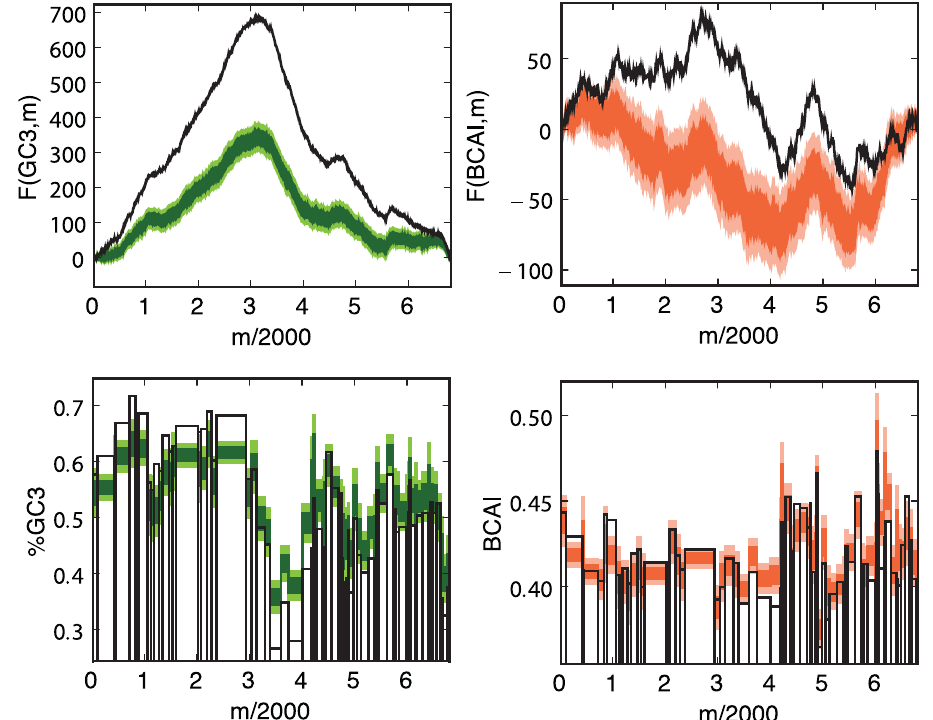
Figure 5. Observed and randomized landscapes for lambda phage. Observed landscapes are shown along with randomized landscapes associated with the green and orange tests. The green randomization procedure tests the significance of the GC3 landscape controlling for the observed CAI (actually, BCAI) variation across the genome. The orange randomization procedure tests the significance of the BCAI landscape, controlling for the observed GC3 variation across the genome. Both tests preserve the amino-acid sequence exactly. Both observed landscapes lie outside the distribution of random trials, indicating there is non-random GC3 content controlling for CAI, and non-random CAI content controlling for GC3.